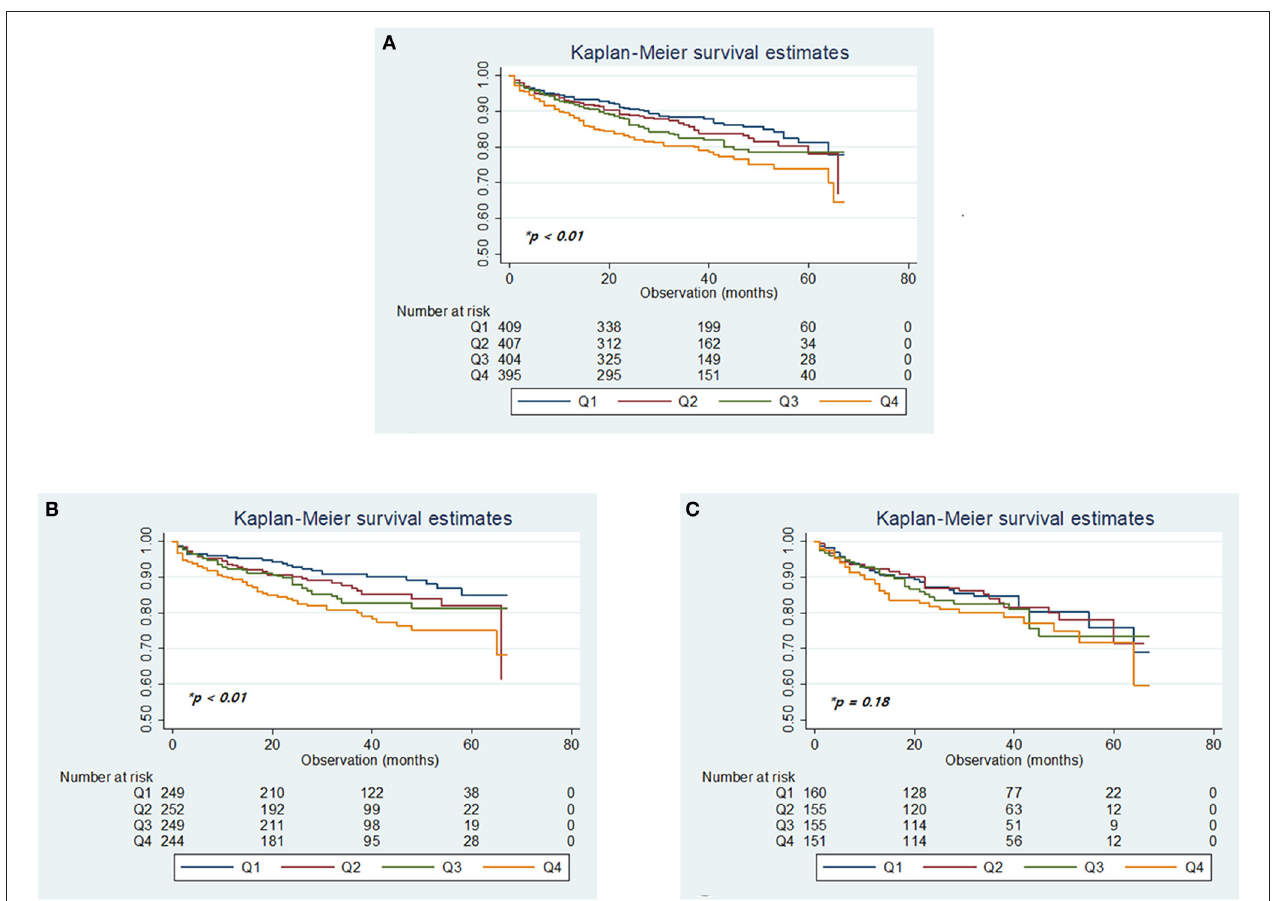
FIGURE 3 | Kaplan–Meier plots of overall survival according to the quartiles of QTc intervals in the total cohort (A) , in men (B) , and women (C) . * p- values determined using the log-rank